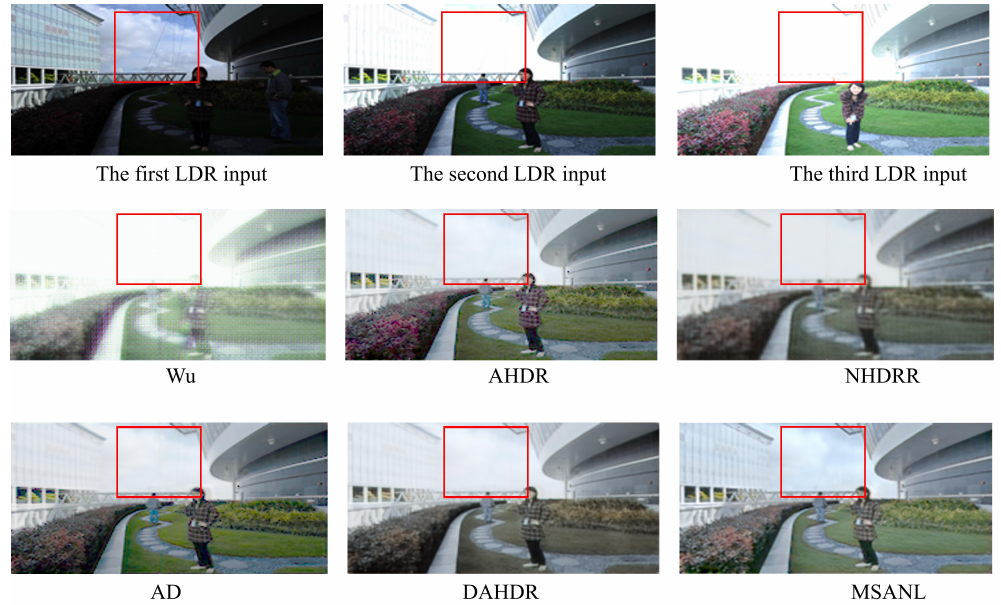
Figure 11. Visual comparison of additional HDR images from the dataset provided in [93]. From left, Wu [28], AHDR [26], NHDRR [30], AD[27], DAHDR [39], and Proposed